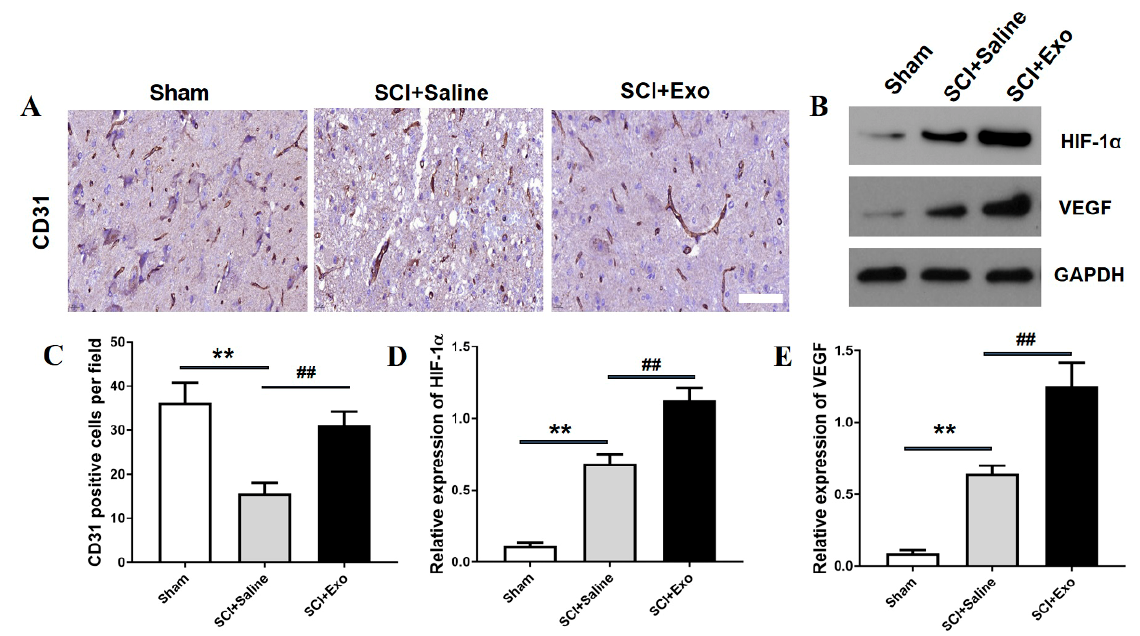
Figure 3. The administration of M2 macrophage exosomes improves angiogenesis post-SCI. The existence of blood vessels in the SC after SCI for 3 days was determined by CD31 ( A ). The number of the CD31+ cells ( C ). The protein levels of HIF-1 α and VEGF were evaluated by WB. GAPDH expression was employed as an internal control ( B , D , E ). Mean ± SD. ** p < 0.01 SCI + saline group versus sham group, ## p < 0.01 SCI + Exo versus saline group. N = 5 per group. Scale bar = 50 μ m.